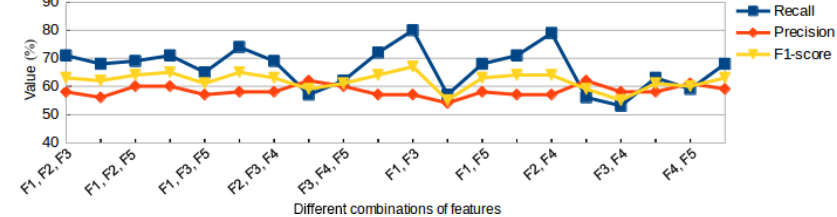
Fig. 3 Overall performance of the classifier with different combinations of